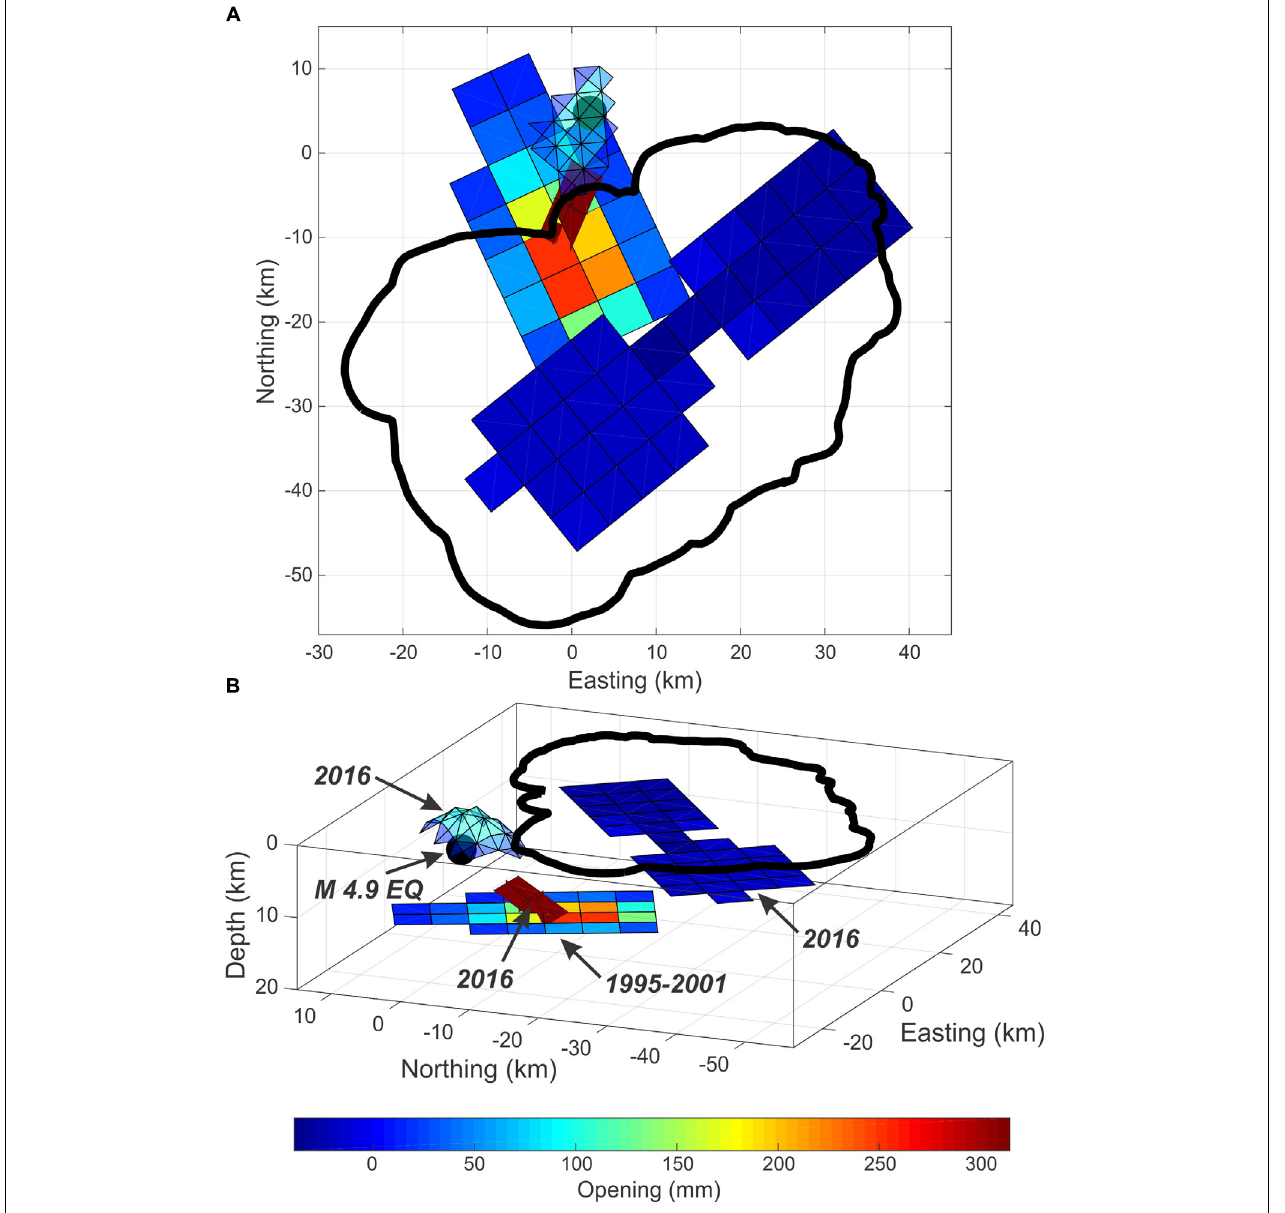
FIGURE 7 | Source models for deformation events discussed in the text. Flat-lying source under north caldera rim is for 1995–2001 uplift episode there. All other sources are for deformation that occurred during 2016, including domed and tabular expansion sources under the north caldera rim and a sill-like contraction source under the caldera floor. Black sphere shows location of March 30, 2014, M 4.9 earthquake (see Figure 6C ). Color bar at bottom shows millimeters of opening. (A) Plan view of sources. (B) Perspective view of sources from